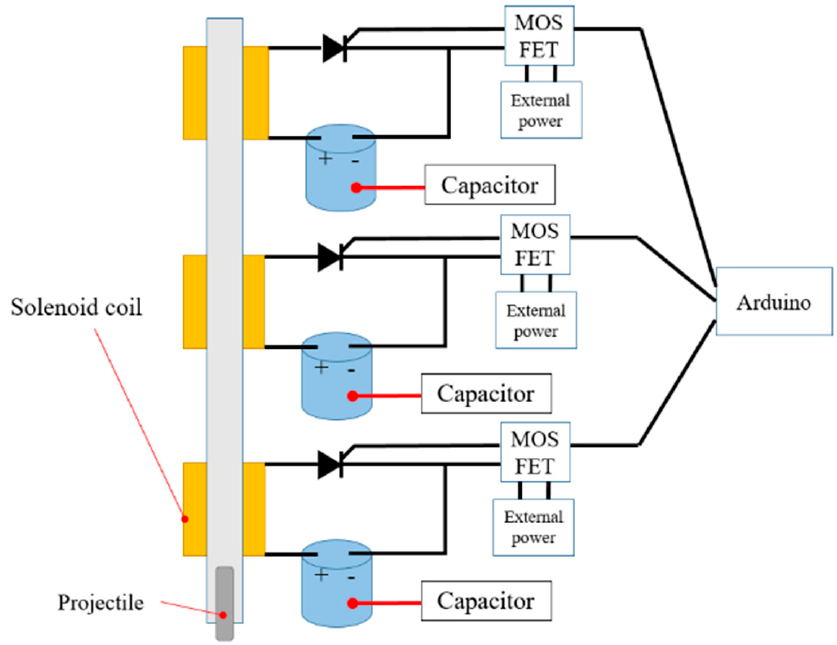
Figure 6. A schematic diagram of the multi − stage coil gun discharging circuit.